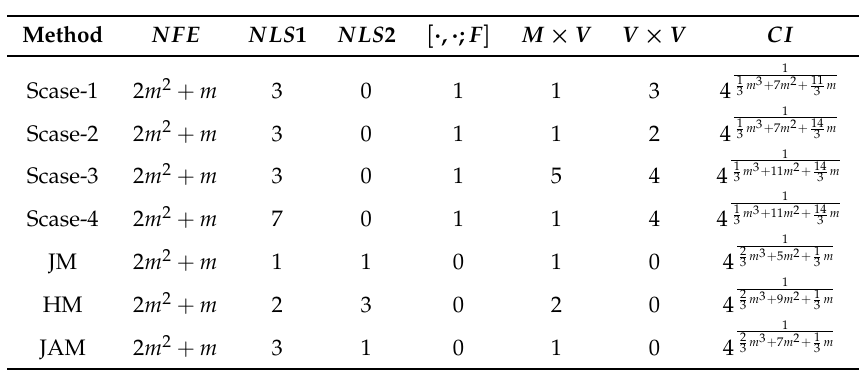
Table 3. Functional evaluations and products-quotients of the methods. NFE , number of functional evaluations; NLS 1, number of linear systems.